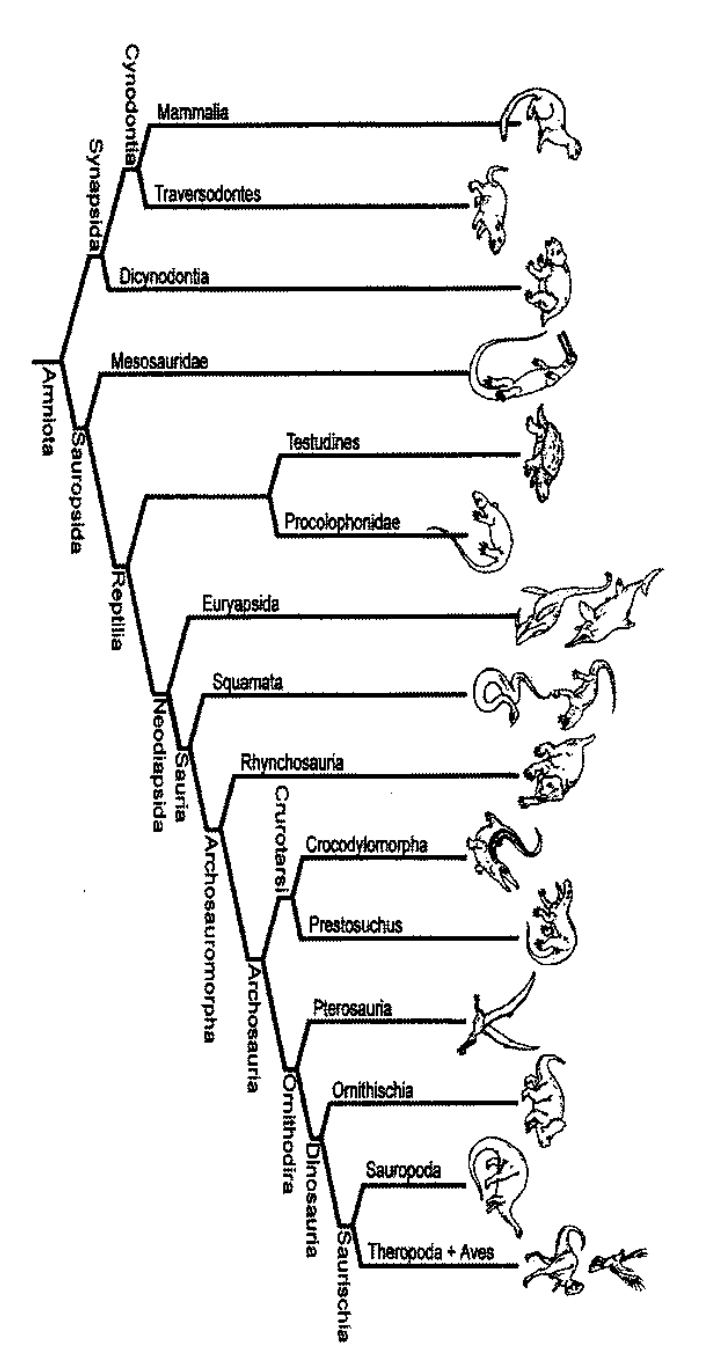
Fig. 5 – Cladogram indicating the relationships of the main groups of Amniota, with emphasis on Reptilia. Note that dinosaurs have a sister group relation with Pterosauria, both forming the Ornithodira (from Kellner et al. 1999b).